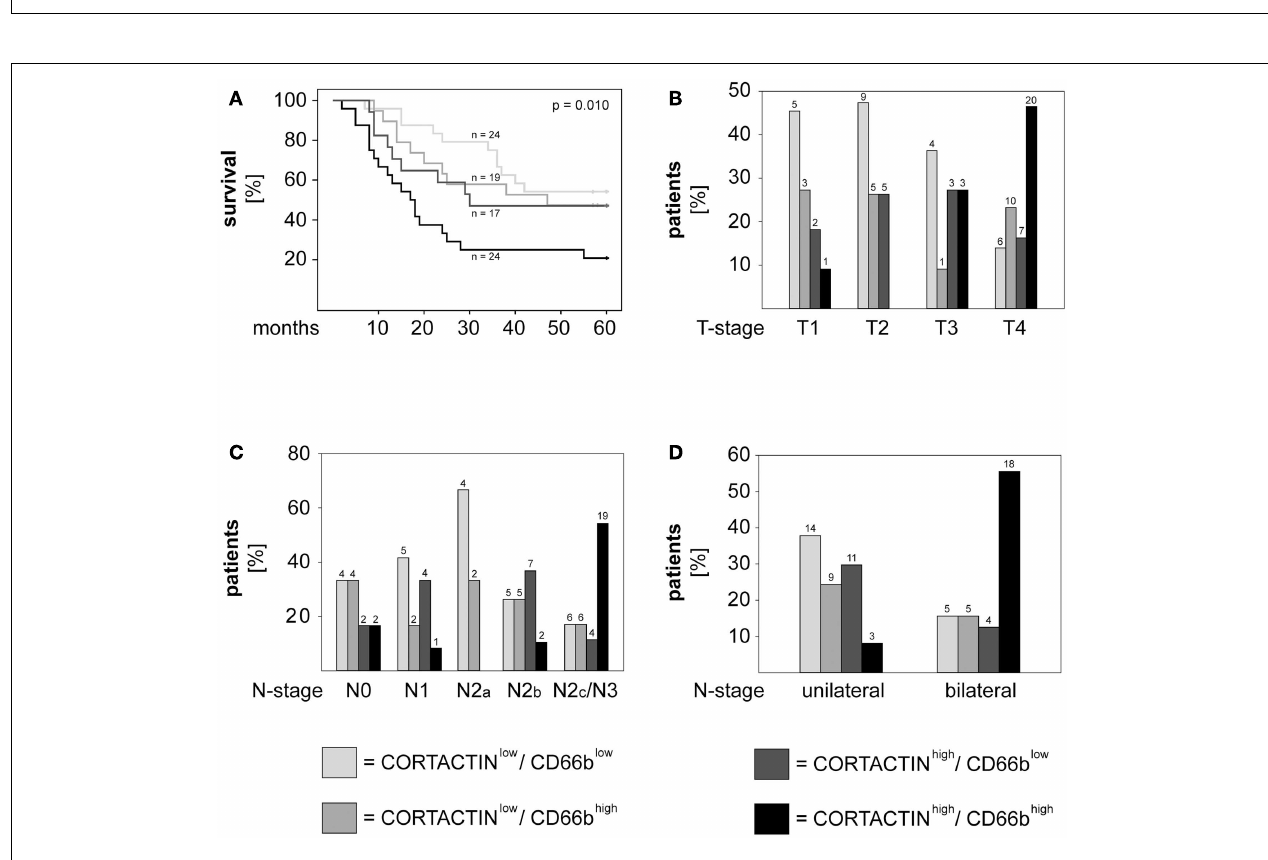
FIGURE 3 | High neutrophilic infiltration associates with poor survival and metastasis to the lymph nodes in orohypopharynx carcinoma patients. (A) Kaplan–Meier 5-years survival curves were plotted for patients with low versus high neutrophilic infiltration and statistical analysis was performed with the log-rank test. (B) Graphical depiction of N-stage in patients with high versus low neutrophilic infiltration. Statistical testing was